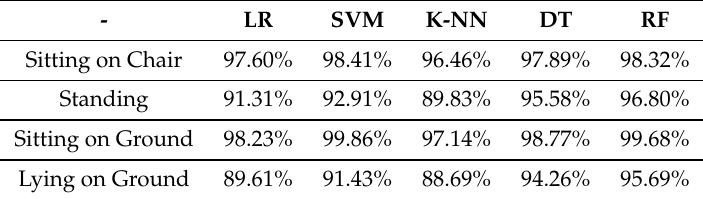
Table 13. F-1 score using different algorithms for two